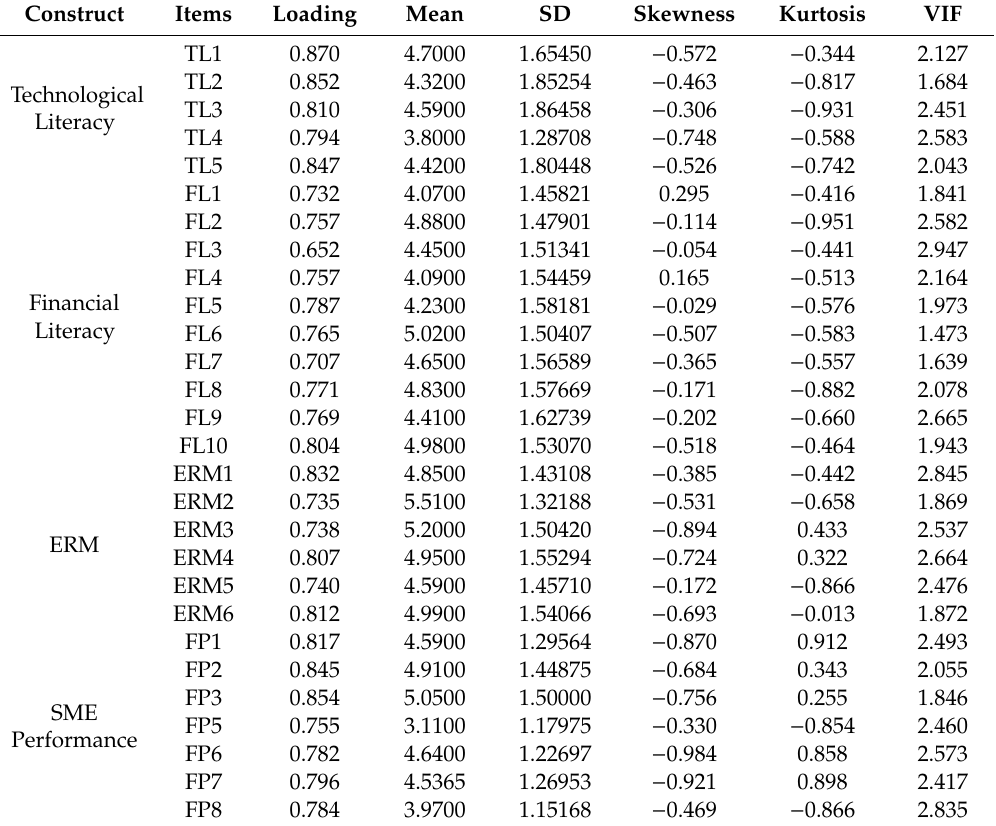
Table 2. Reliability, validity, and descriptive statistics of the constructs. VIF—variance inflation factor; ERM—enterprise risk management; SME—small and medium-sized enterprise.